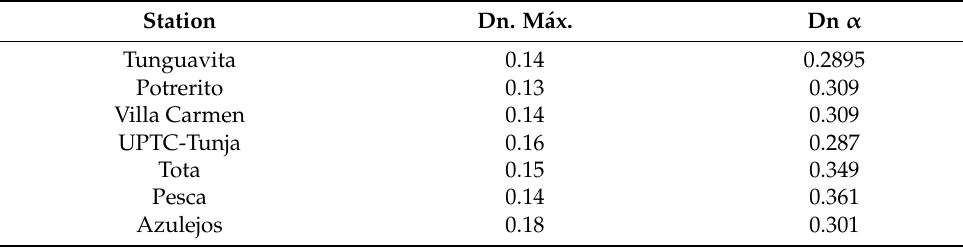
Table 2. Kolmogorov–Smirnov test results.